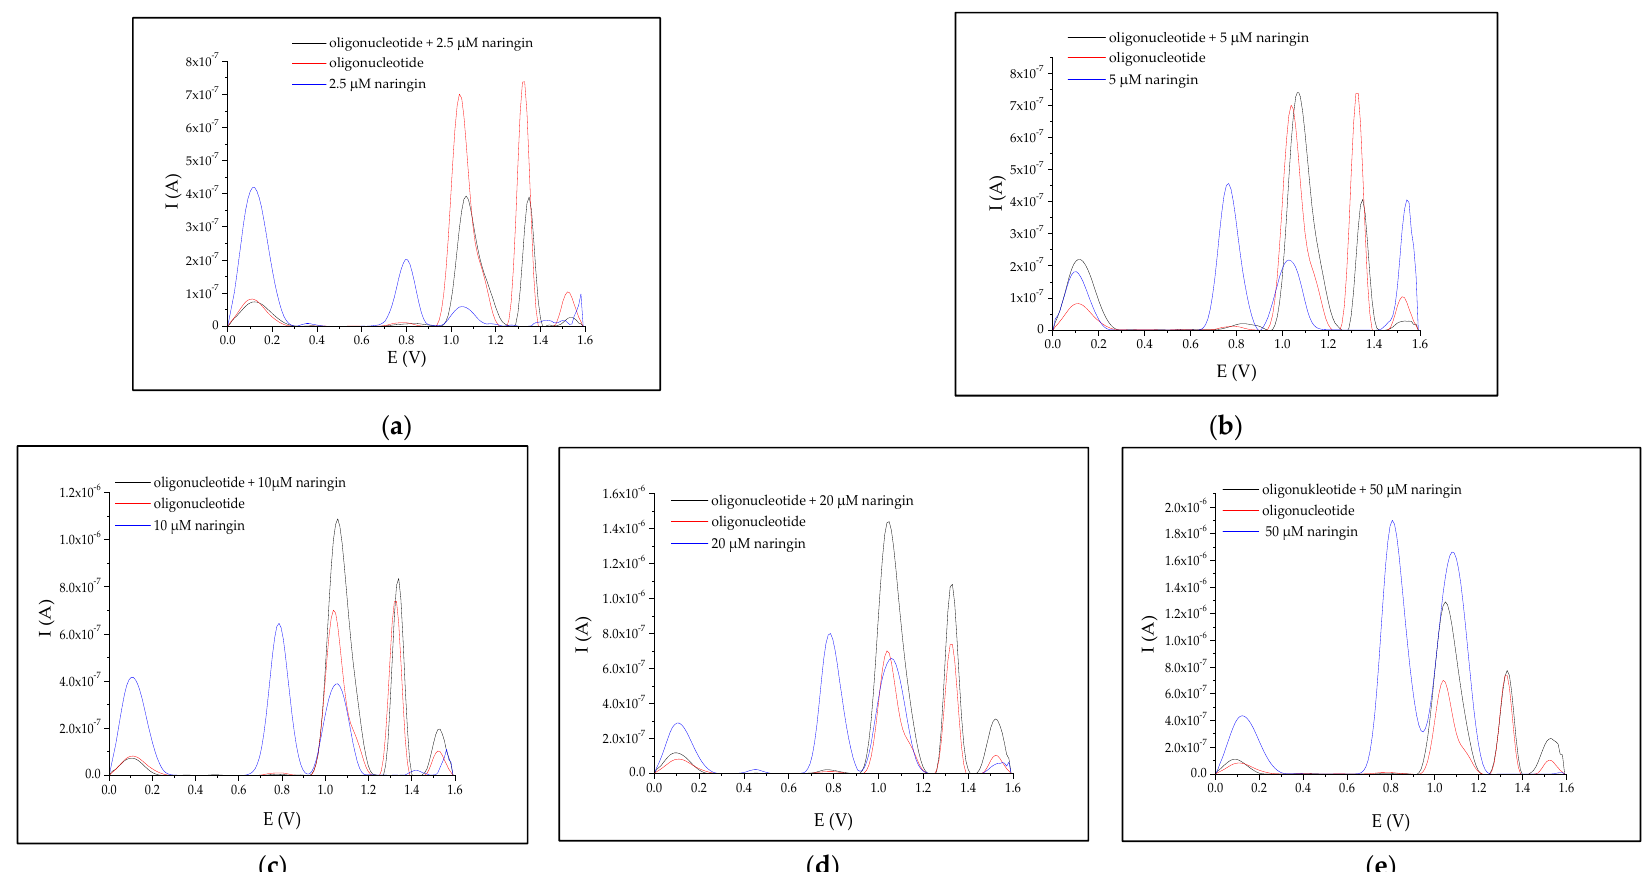
Figure 2. Average voltamperograms of tested oligonucleotide before (red line) and after (black line) interaction with growing concentrations of naringin ( a – e) .